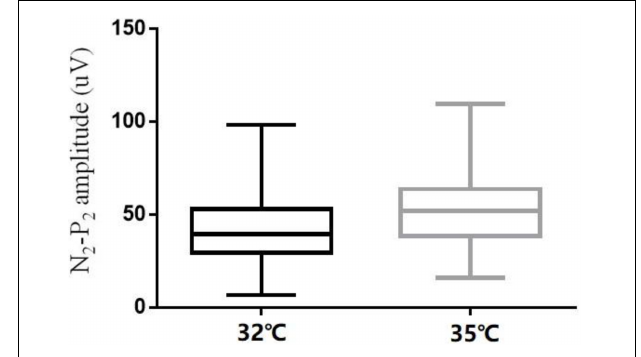
FIGURE 6 | N 2 -P 2 amplitude at the right forearm for different baseline temperatures (32 and 35 ◦ C).